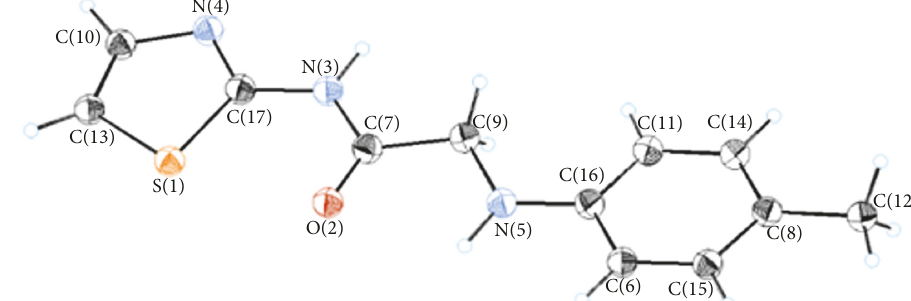
Figure 1: X-ray crystallographic drawing of molecule 3b